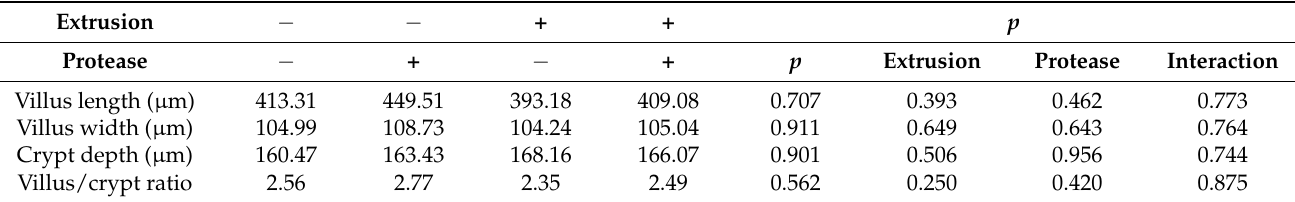
Table 7. The morphometric parameters of the pigs’ ileum ( n = 8).